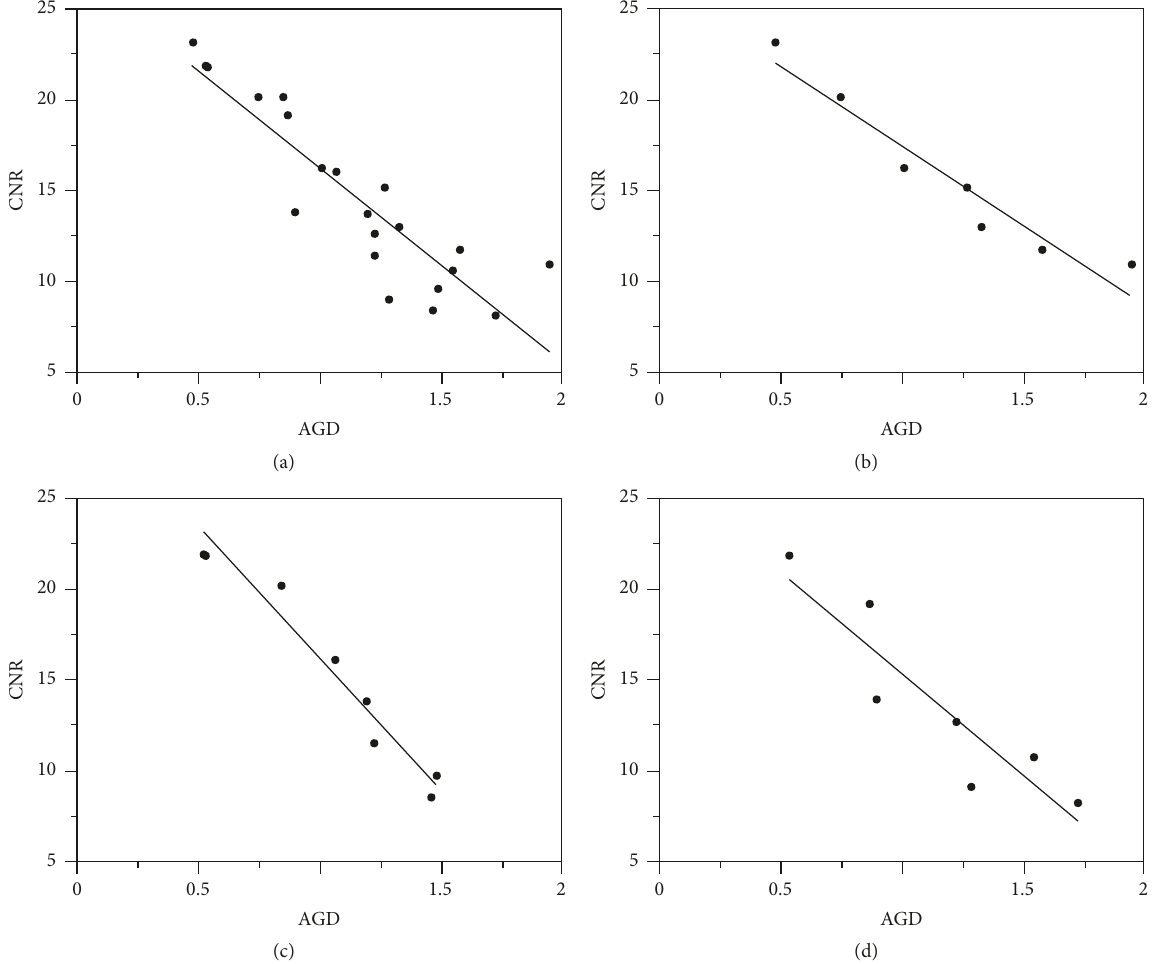
Figure 4: Correlationbetween the AGD and CNR (a)across all three mammary gland ratios, and in (b) modelA (30/70),(c)model B (50/50), and (d) model C (70/30). AGD: average glandular dose and CNR: contrast to noise ratio.